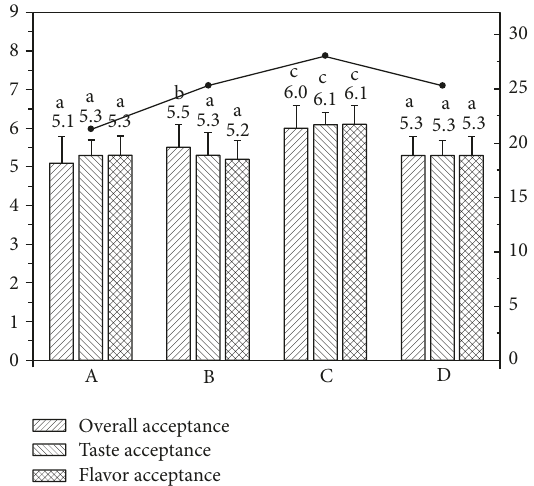
Figure 3: Consumer acceptability test of hawthorn wine. Left ordinaterepresentsscoreofacceptanceandrightordinaterepresents percentage of purchase intention. (A) Wine from the extracted juice with pectase, (B) wine from the extracted juice without pectase, (C) winefromnonextractedpulpyjuicewithpectase,and(D)winefrom nonextracted pulpy juice without